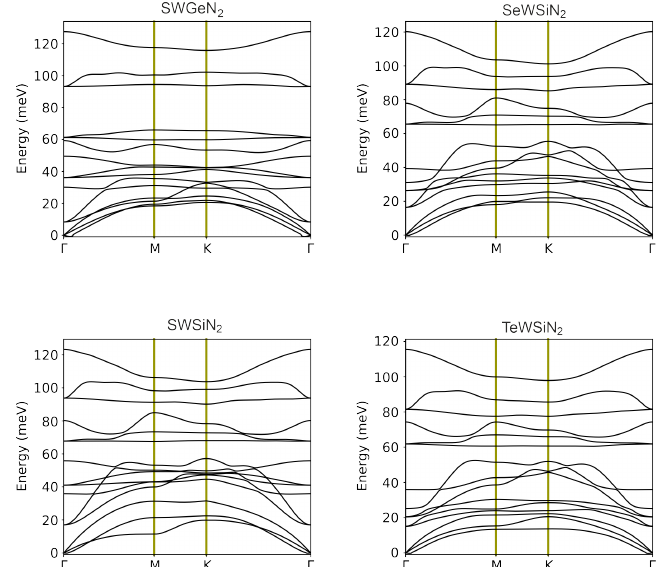
Figure 2. Phonon spectra of X-M-AN 2 monolayers. The three lower branches correspond to acoustic modes TA, LA, and ZA, and the remaining 12 branches represent optical modes. The intersection of the optical branches at the Γ point indicates their